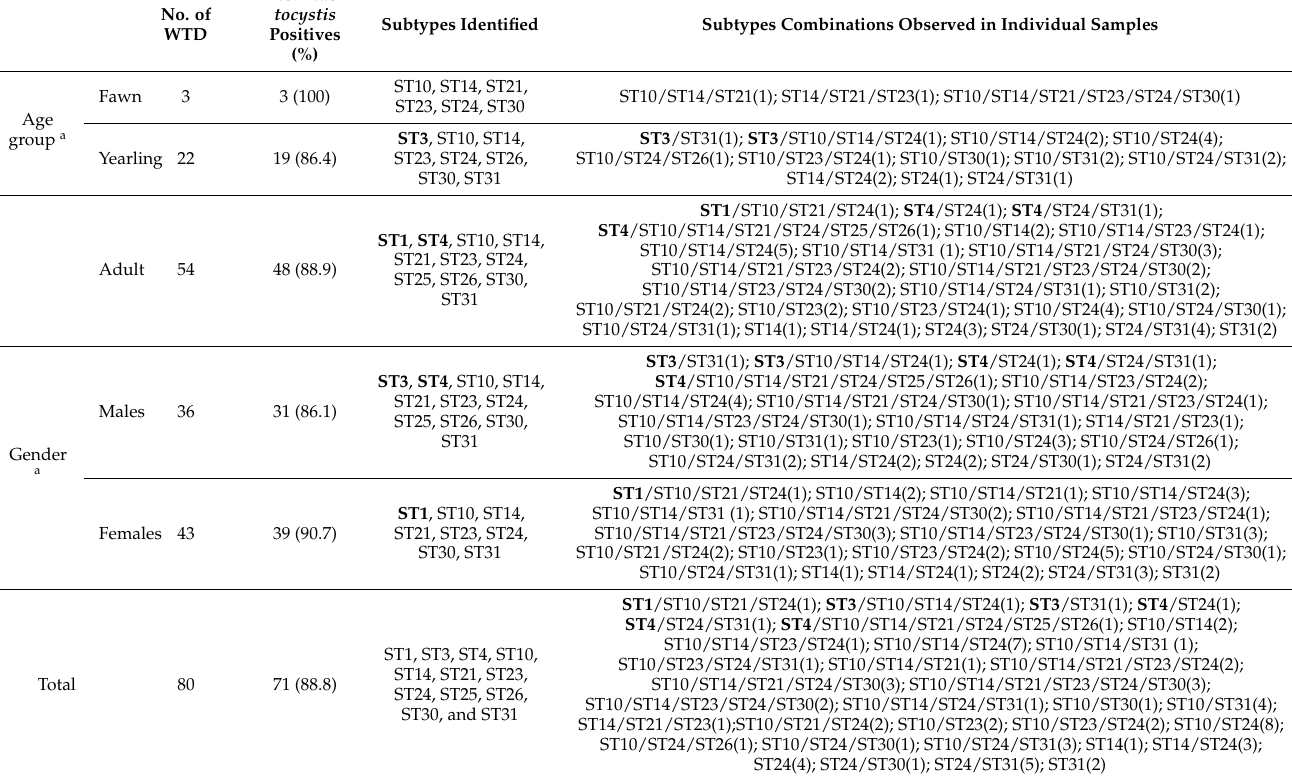
Table 2. Table 2. Blastocystis prevalence and subtypes observed in white-tailed deer (WTD) in Maryland, USA by age and gender. Potentially zoonotic subtypes are in